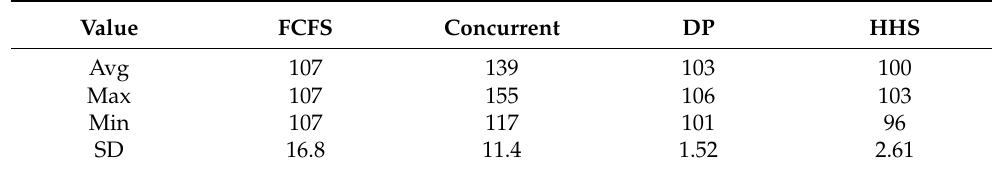
Table 6. Application loop delay statistics for FCFS, Concurrent, DP, and HHS based on the number of